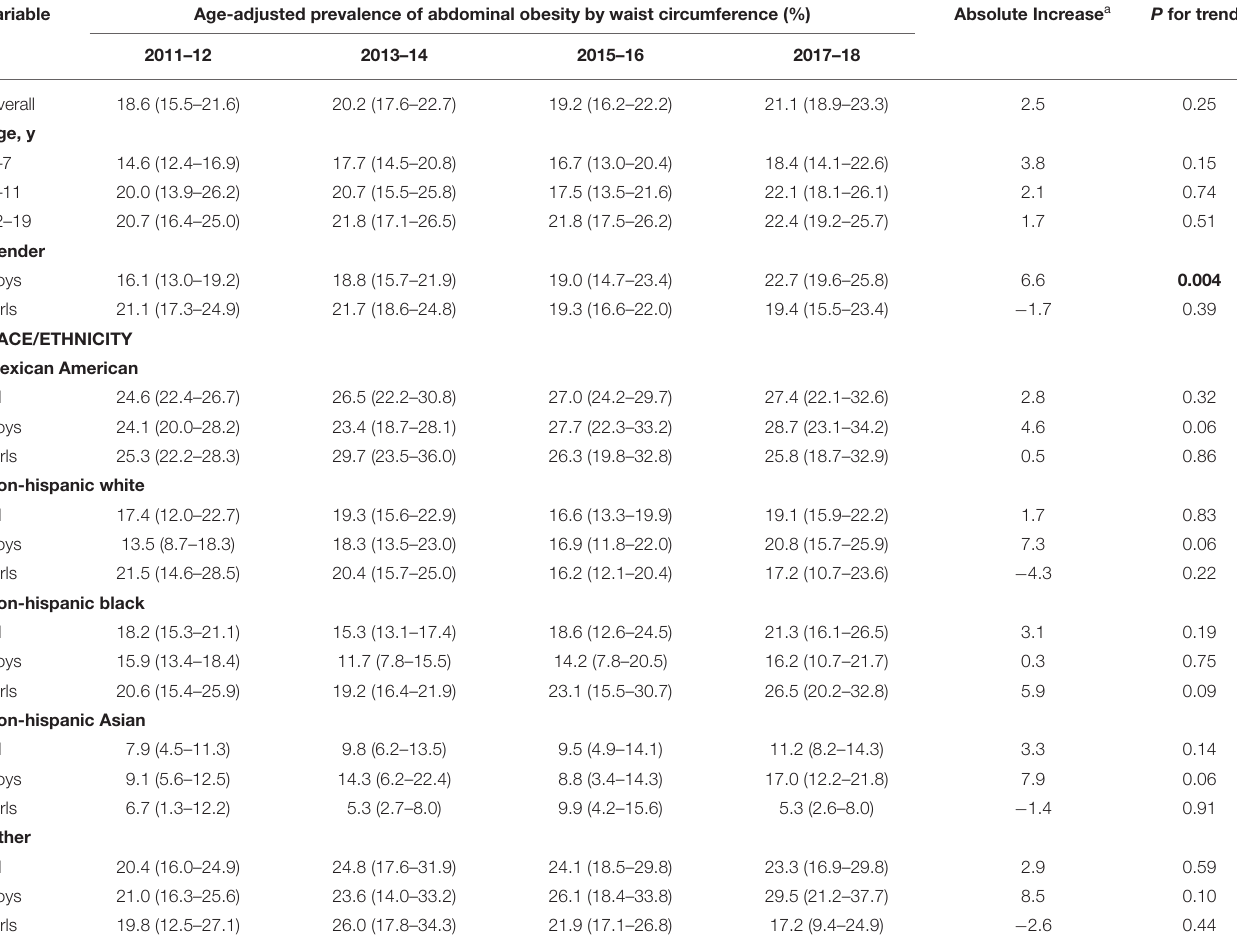
TABLE 3 | Trends in age-adjusted prevalence of abdominal obesity by waist circumference among US children aged 2–19 y, NHANES 2011–2012 to